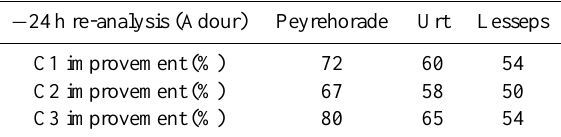
Table 1. C1, C2, C3 improvement between Free run and Assim run over the twenty four hours before the reference time. Average of seven flood events in the Adour catchment, at Peyrehorade, Urt and Lesseps.